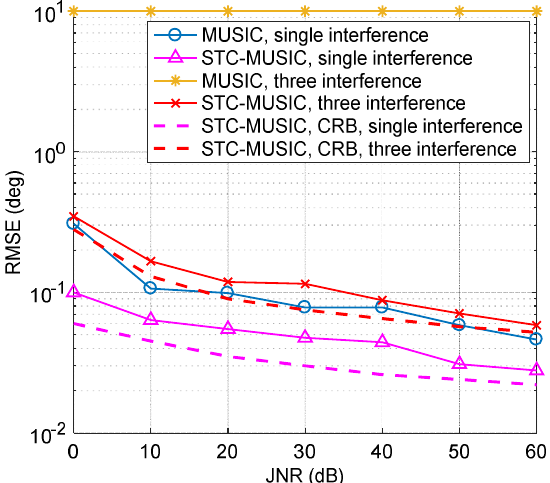
Figure 12. The direction-finding RMSEs of the MUSIC algorithm and STC-MUSIC algorithm under different JNR cases.